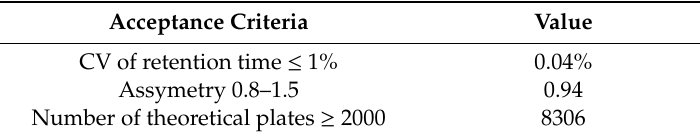
Table 1. System suitability test ( n =